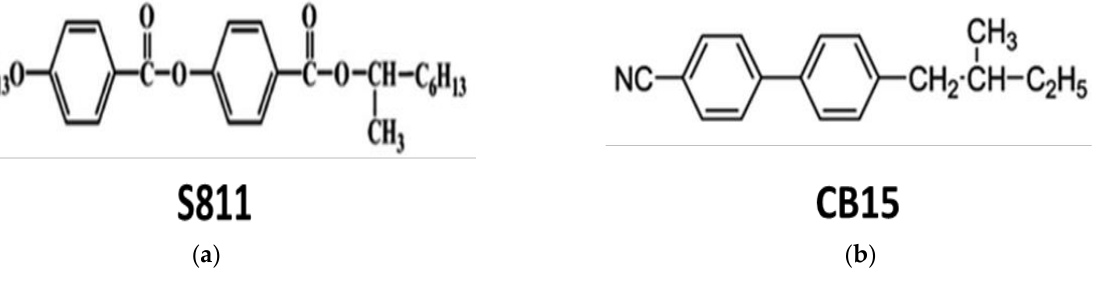
Figure 8. Chemical structures of two chiral dopants: ( a ) S811, ( b ) CB15 . For each mode used as a LC shutter, response time, voltage-transmittance of black and transparent, and contrast ratio were measured to optimize the fabricating conditions, according to electro-optical characteristics. Then the process conditions for fabricating the proposed transparent OLED display were optimized. To experiment the proposed polarized mode and non-polarized mode transparent OLED display, we have fabricated the transparent display panel consisting of an OLED cell for the image part and a LC cell for the window shutter on the single glass substrate, as shown in Figure 9.